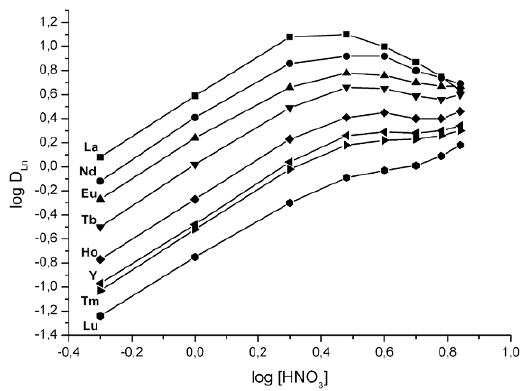
Figure 3. The effect of HNO concentration in the aqueous phase 3 on the extraction of lanthanides(III) with 0.01 M solutions of compound 1 in